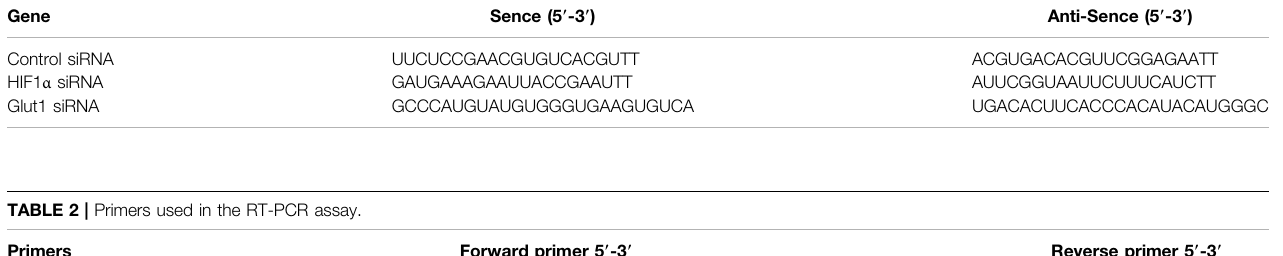
TABLE 2 | Primers used in the RT-PCR